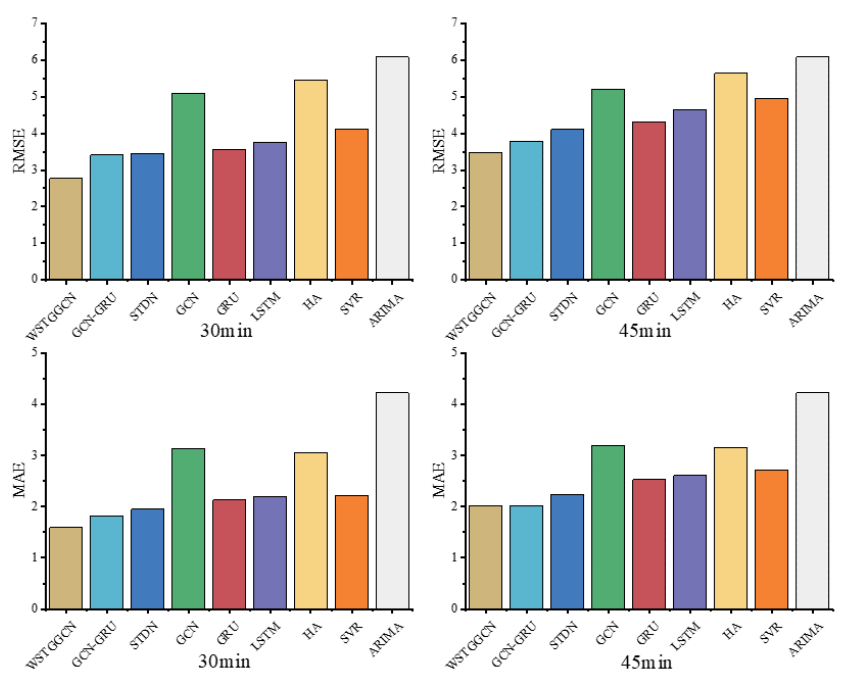
Figure 12. The left half shows the RMSE and MAE for 30 min for different models, the right half shows the RMSE and MAE for 45 min for the different